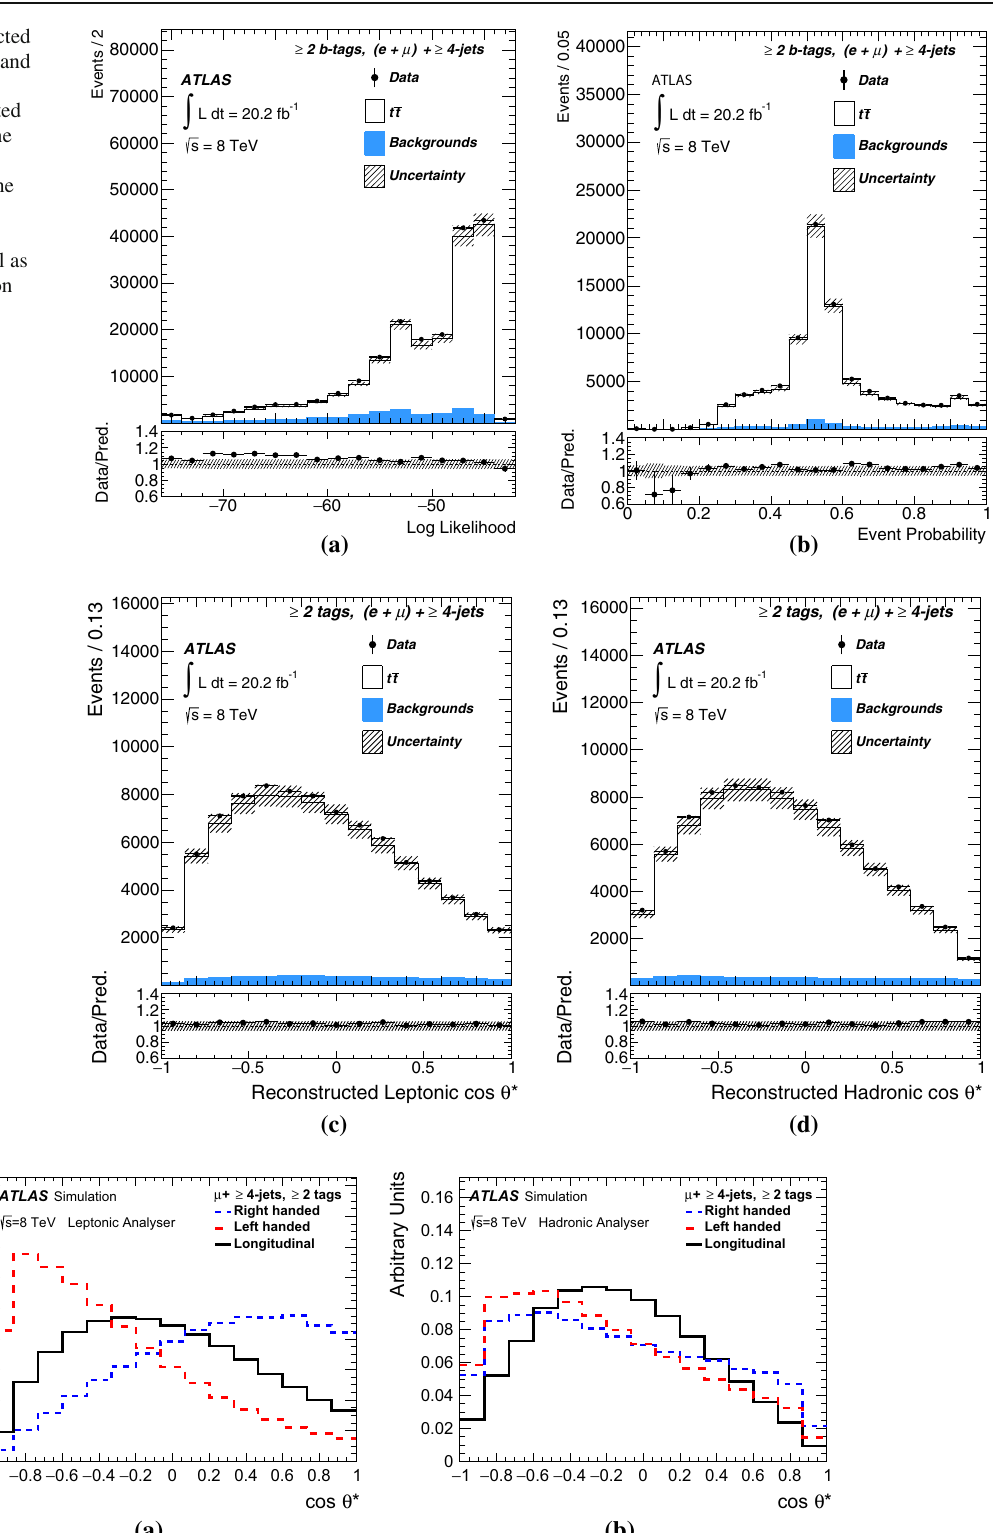
Fig. 3 Templates of the cos θ ∗ distributions for the individual helicity fractions in the μ + jets channel with ≥ 2 b -tags for the a leptonic and b hadronic